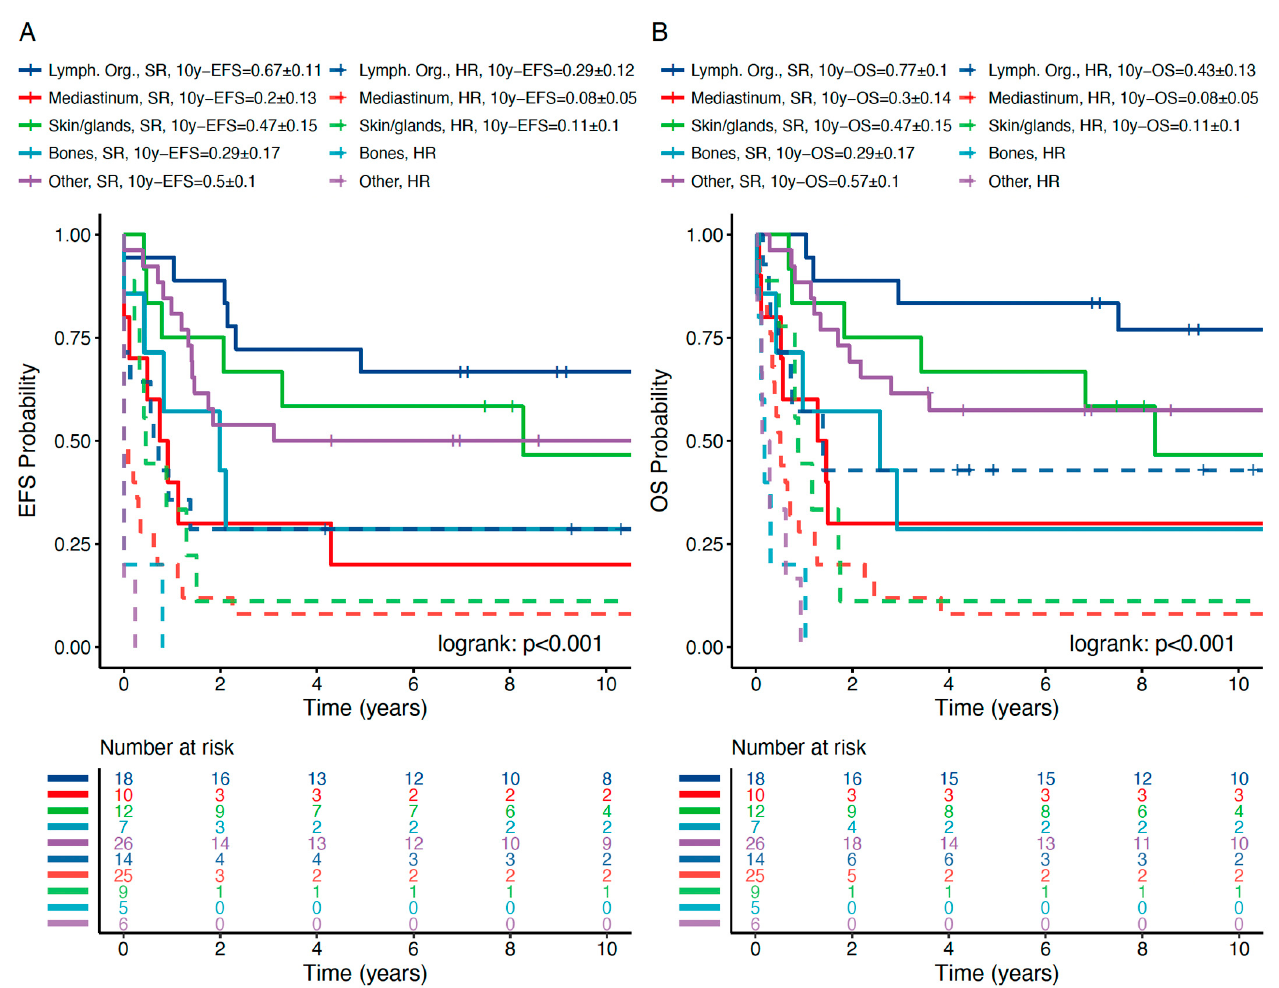
Figure 5. Ten-year pEFS ( A ) and pOS ( B ) of OEMR subgroups stratified by HR and SR criteria. HR OEMR is associated with significantly decreased 10-year pEFS and pOS except in mediastinal subgroup. Calculation based on Kaplan–Meier analysis. Pairwise log-rank applied in subgroup analysis. p < 0.05.